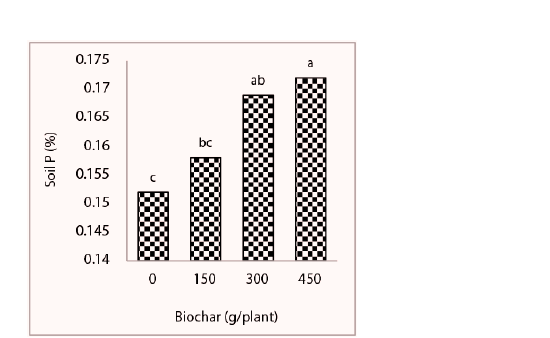
Figure 5 The effects of the interaction of drought stress and biochar on soil P content. Mean values with the same letters are not significantly different at p ≤ 0.05 according to LSD test.